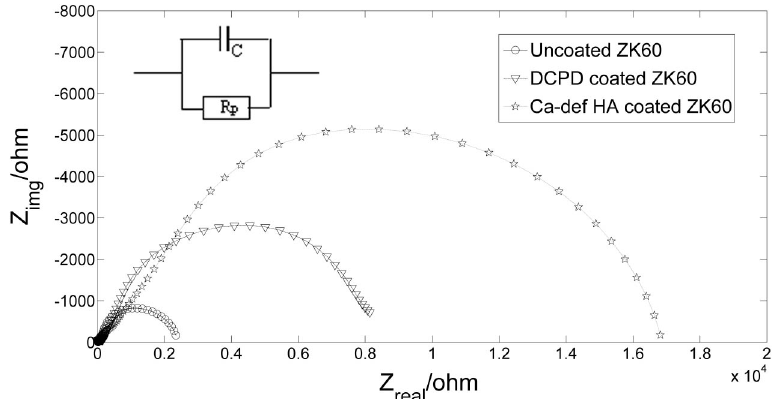
Figure 8. Nyquist curves of the samples obtained in SBF at 37